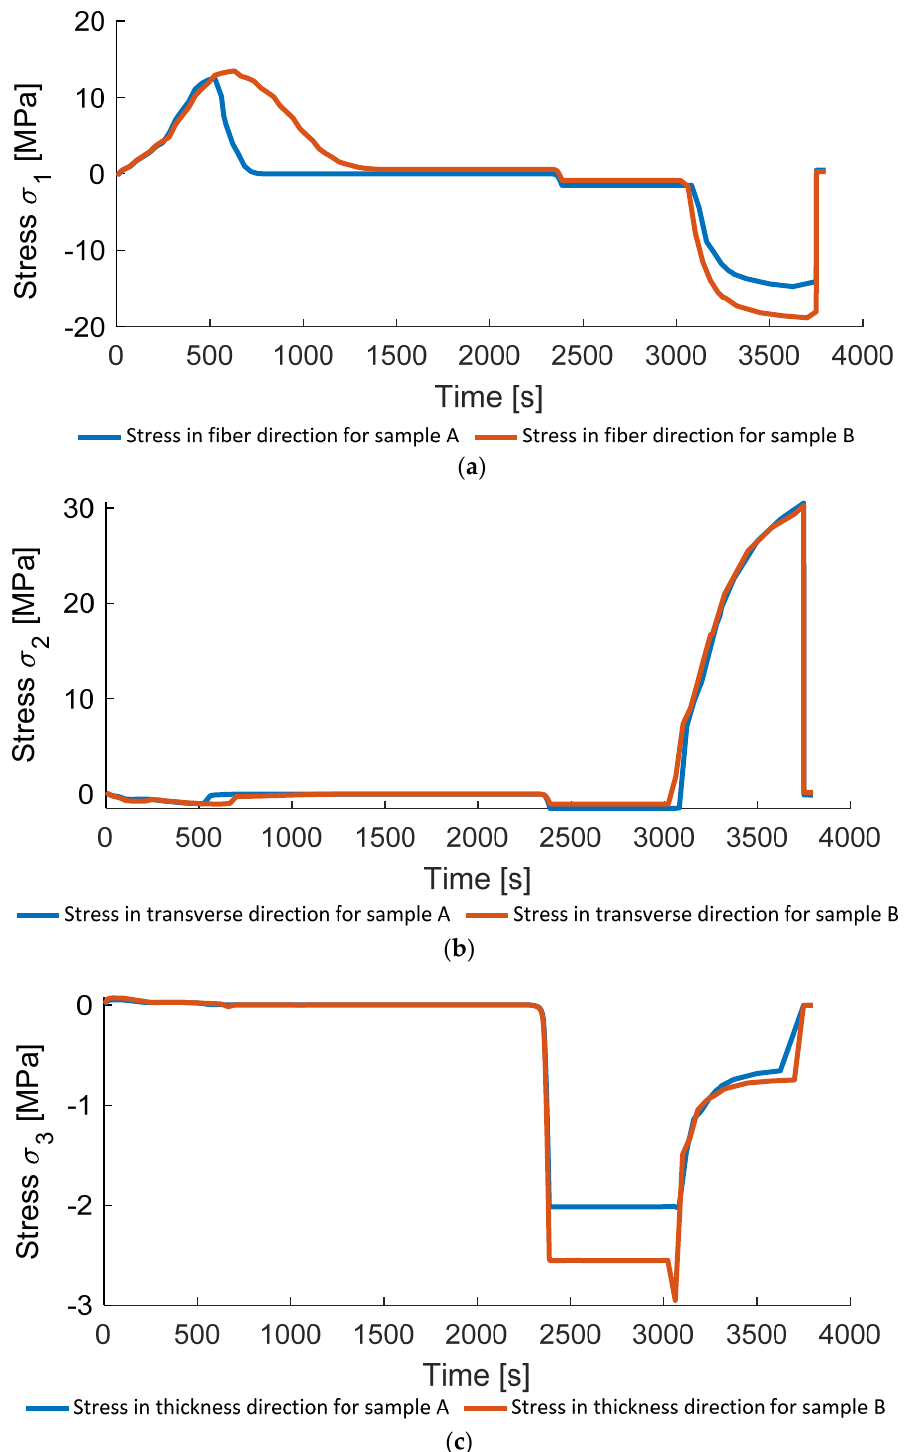
Figure 22. Directional stresses in samples A and B: ( a ) in fiber direction; ( b ) transverse to fiber direction; ( c ) in thickness direction.